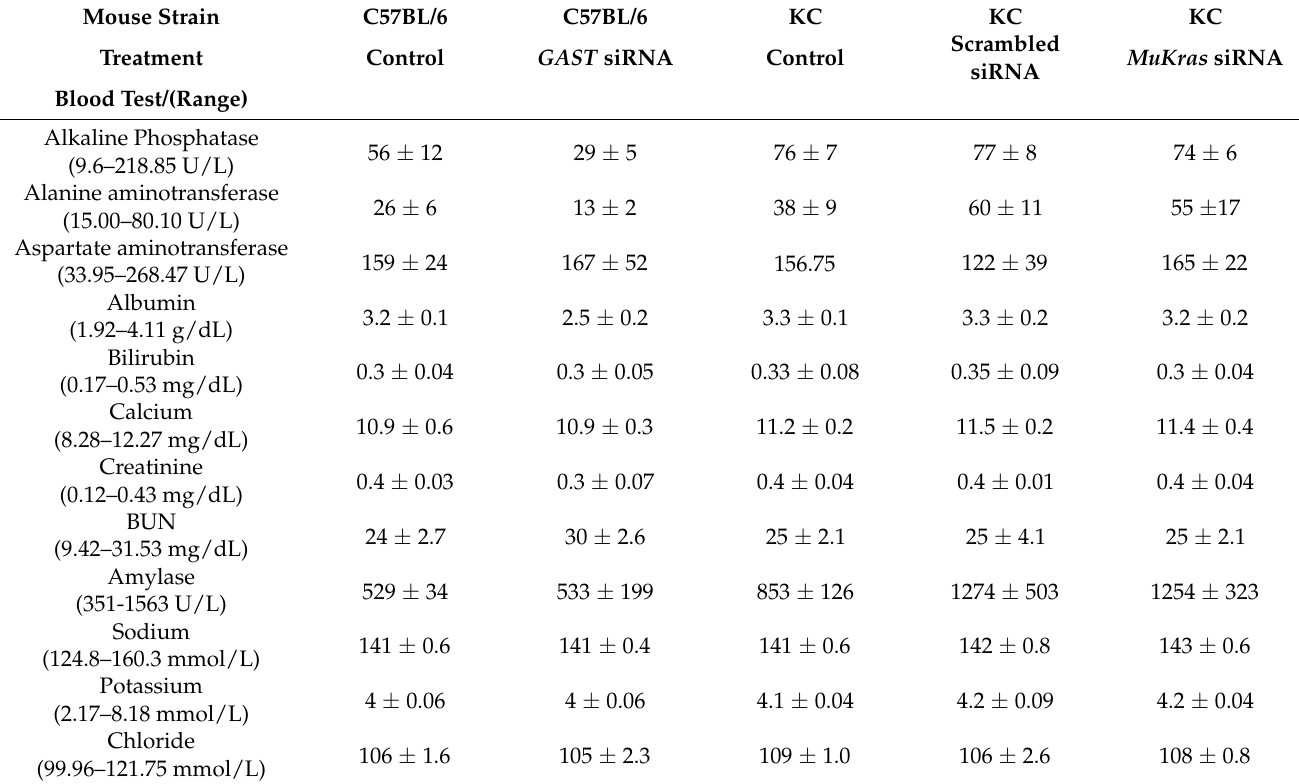
Table 1. Serum chemistries in wild type C57BL/6 mice or mutant Kras mice